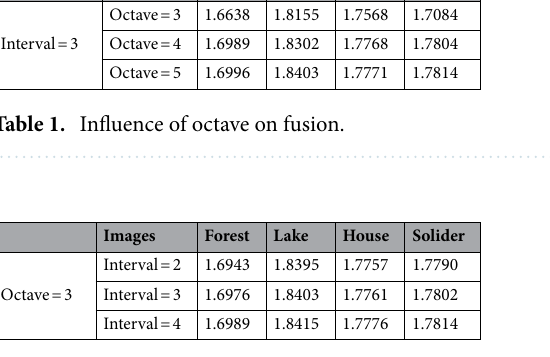
Table 2. Influence of interval on